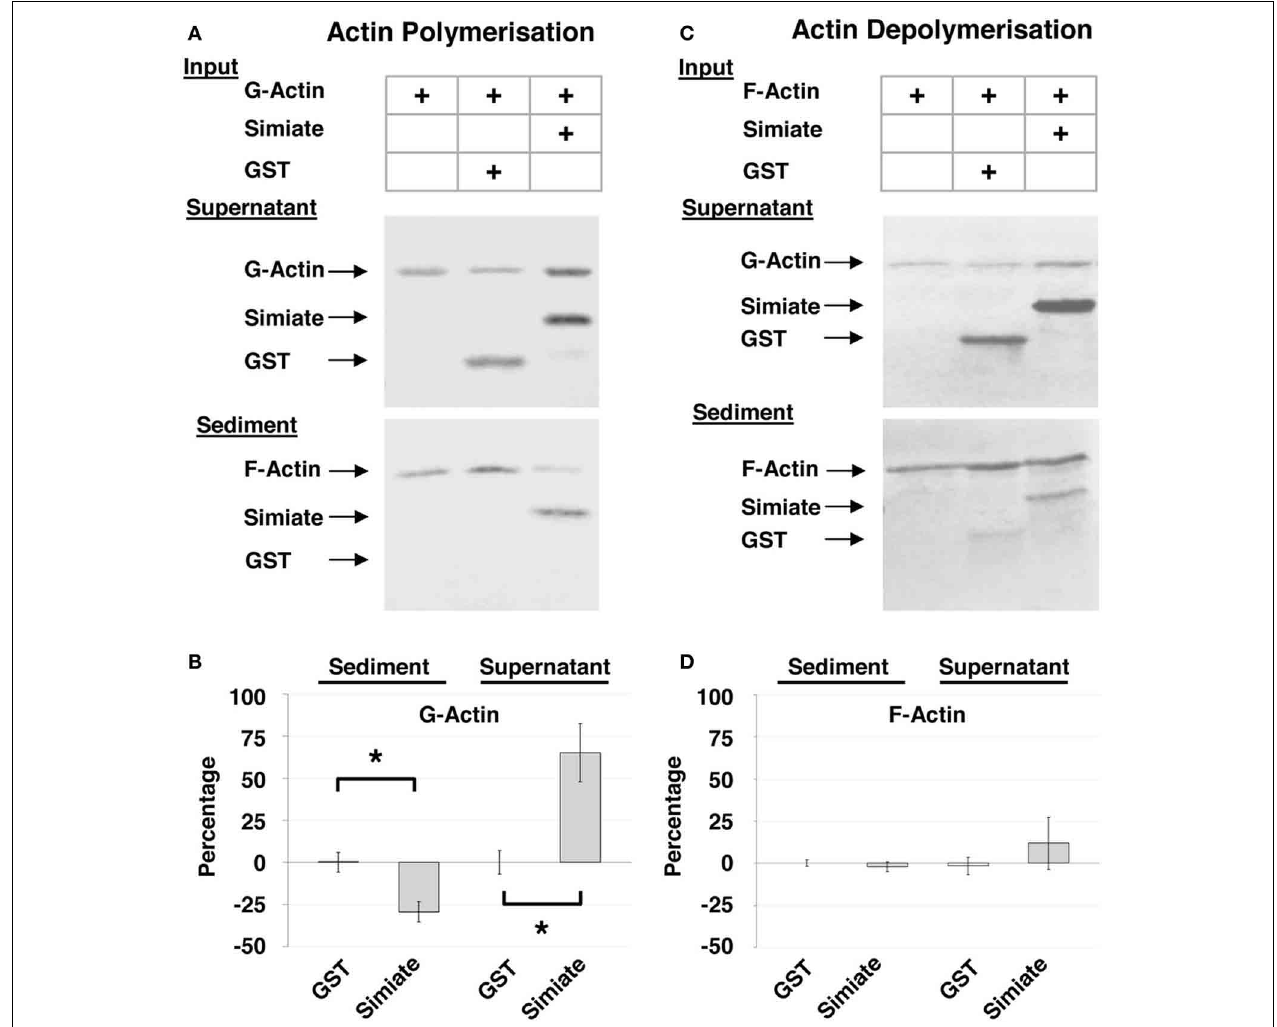
FIGURE 2 | Cosedimentation of Simiate and Actin. (A) Cosedimentation assay with G-Actin. The pictures show a representative Ponceau staining out of five independent experiments. (B) Actin sedimentation. The graph illustrates the deviation from Actin control (Actin alone equals 0%) in percent